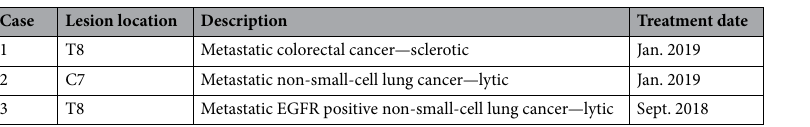
Table 1. The metastatically involved vertebrae utilized in this study.